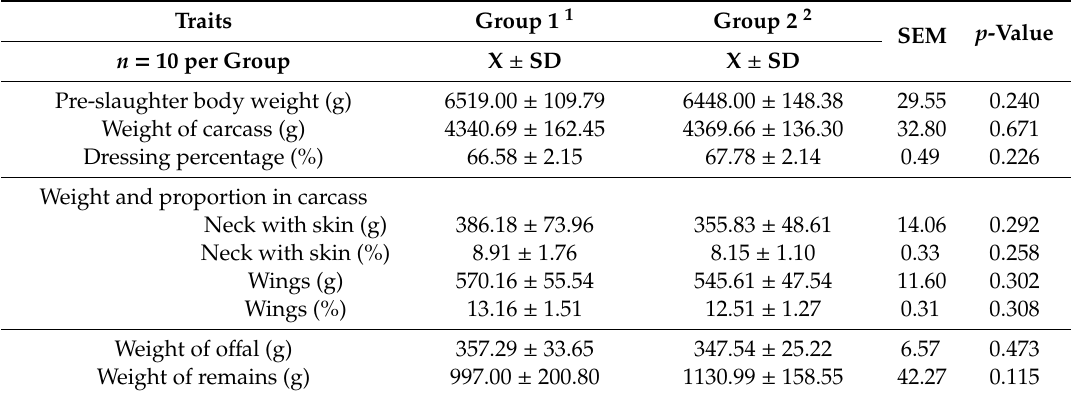
Table 4. Post-mortem parameters (mean; ± SD; SEM) in 16-week-old geese.